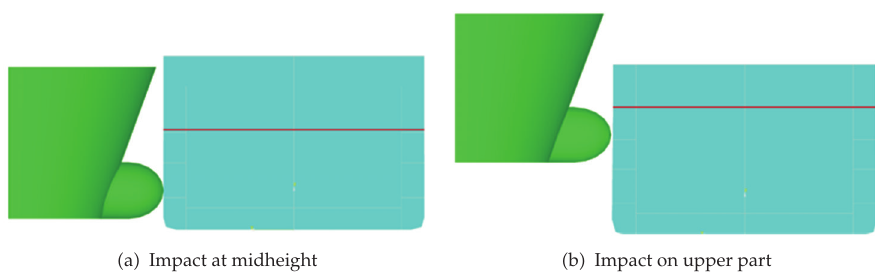
Figure 13: Crude oil carrier against container vessel: collision scenarios.